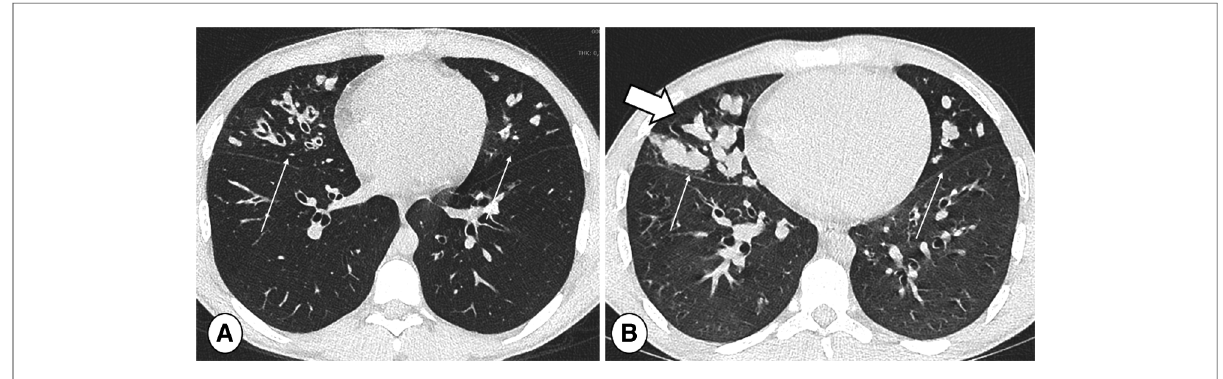
FIGURE 4 End-inspiratory CT of a cystic fi brosis patient ( A ) without and ( B ) with respiratory tract exacerbation, lung window. Note bronchiectasis and mucus plugs, especially in the middle lobe and lingula (thin arrows). The only difference indicating RTE is an increase in central mucus plugs (thick arrow).